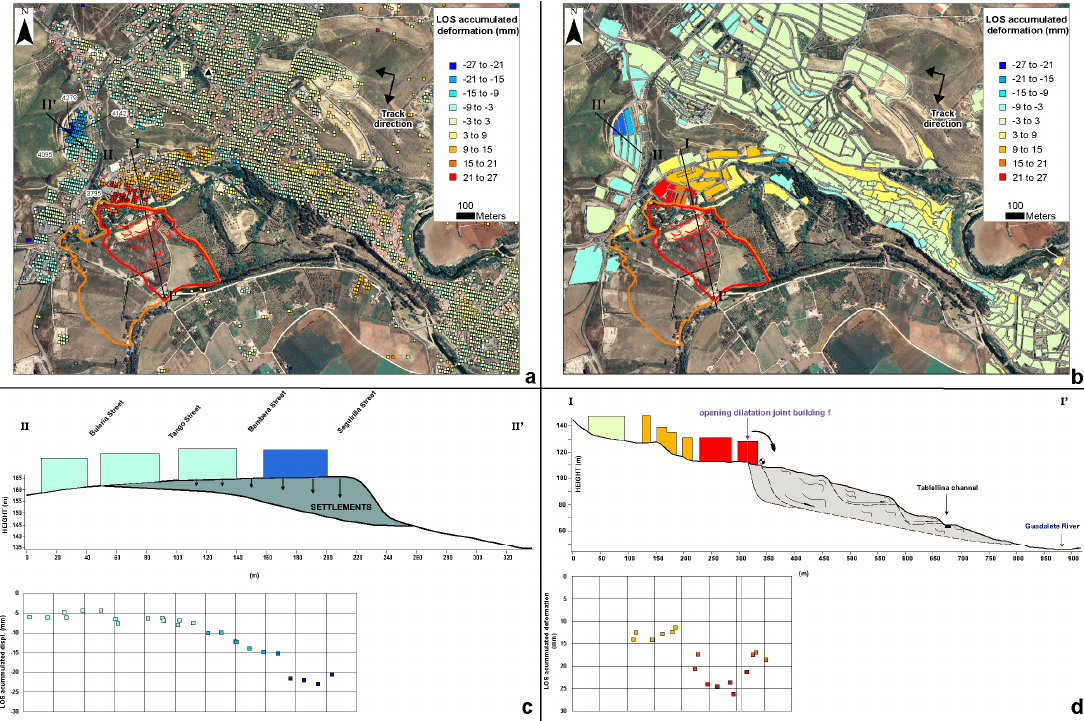
Figure 7. ( a ) Accumulated line-of-sight (LOS) displacement map. The reference point used for A-DInSAR processing is marked with a black triangle. ( b ) city block accumulated LOS displacement for the period April 2011–February 2012. Positive values indicate movement towards the satellite. Black arrows at the upper right of the scenes indicate the descending track direction of the satellite and right-looking mode. Landslide features and the Tablellina channel are depicted in both scenes. ( c ) Pueblos Blancos cross section with buildings (earth fill in green) and projected accumulated LOS displacement pixels along the cross section line II–II’. ( d ) La Verbena landslide cross-section with buildings (depleted mass in grey) and projected accumulated LOS displacement pixels along the cross section line I–I’. Building f and inclinometer S-1 are depicted (Figure 5f).